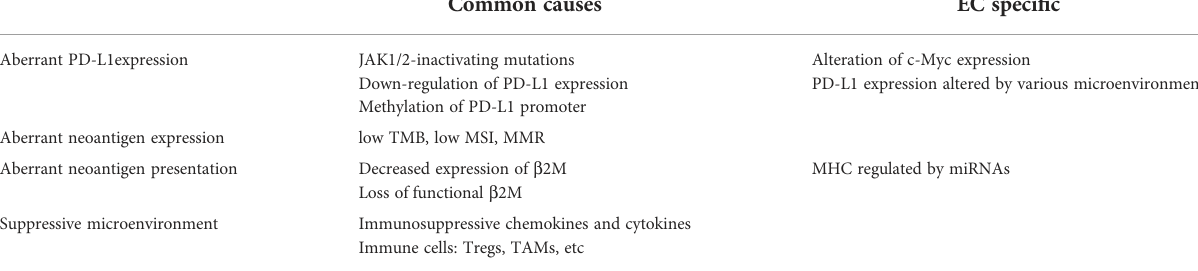
TABLE 1 The common mechanisms of resistance to PD-1/PD-L1 inhibitors in EC and other